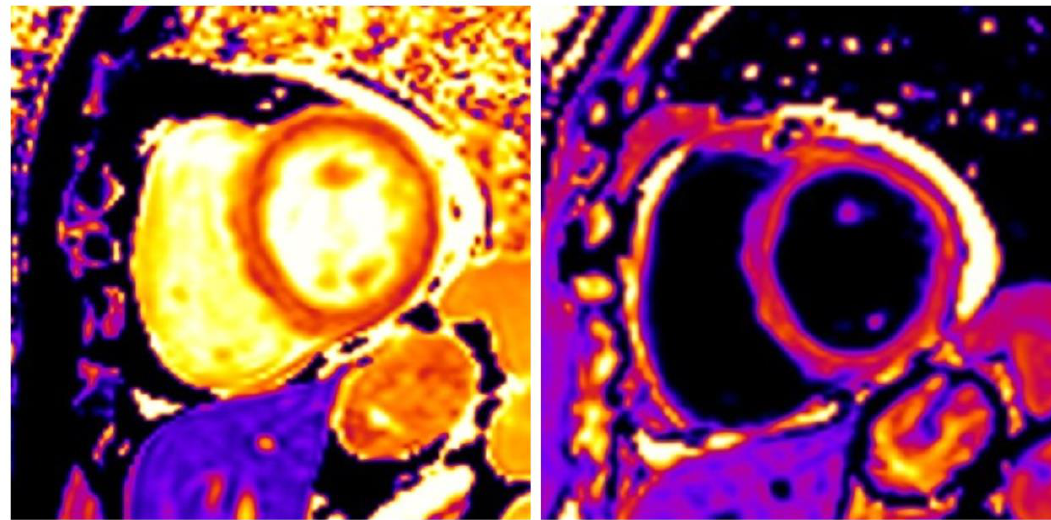
Figure 2. Native and postcontrast T1 mapping in the midventricular short axis level of the left ventricle (LV) in a patient with inflammatory cardiomyopathy. The left image was derived before the administration of a GBCA. The myocardial wall is shown in an inhomogeneous deep orange color which corresponds to pathologically elevated native T1 values. The right one was taken after the administration of the agent. It is worth noting that postcontrast T1 values are influenced by factors other than tissue characteristics such as the agent’s dosage and the time of the imaging. An algorithm that combines native and postcontrast T1 values allows us to calculate a more tissue specific parameter, the ECV, in areas of interest.